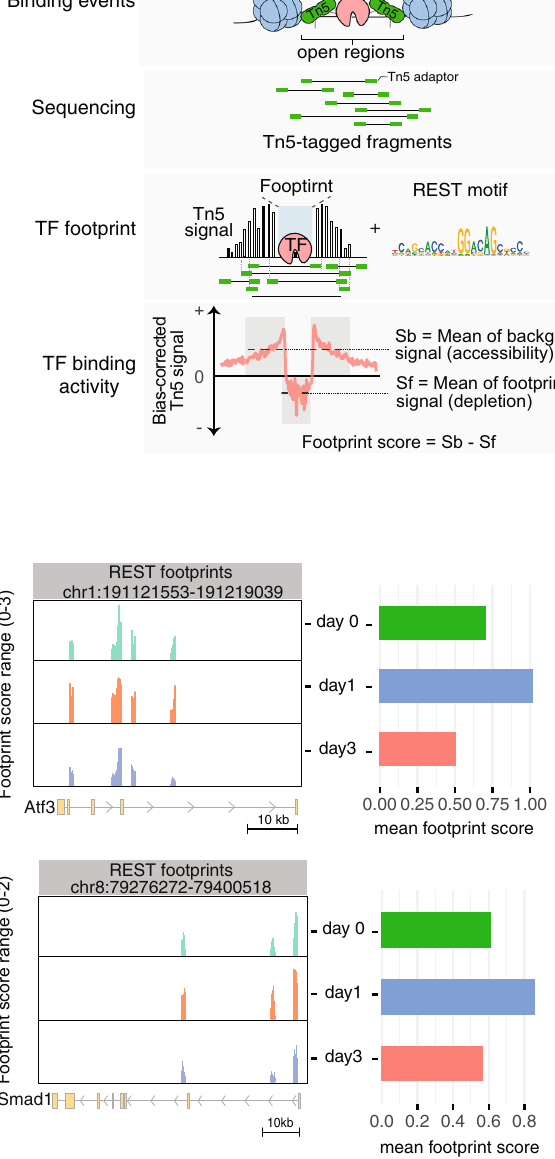
expression of d/n REST increased axon regeneration 55% above the levelachievedwithd/nRESTexpressionalone(Fig.8d,e).RGCsurvival was elevated to the same extent as with d/n REST expression alone (Fig. 8f).